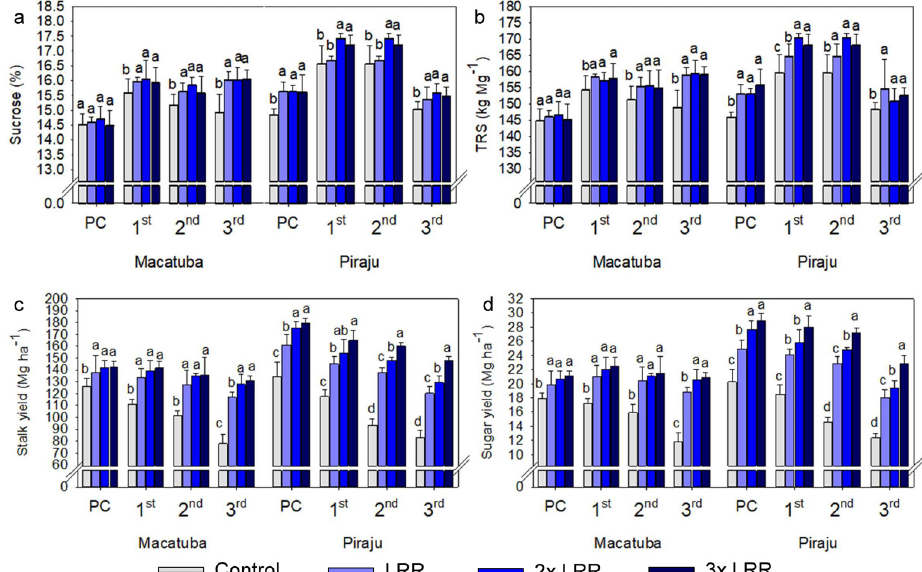
Figure 6. Sucrose ( a ), total recoverable sugar (TRS, b ), and yields of stalks ( c ) and sugar ( d ) under increasing lime rates at Macatuba and Piraju under modified deep strip-tillage (MDT) in plant cane and first, second, and third ratoons. Different lowercase letters indicate significant differences between lime rates for each growing season (LSD, p ≤ 0.1). The error bars express the standard error of the mean ( n = 4).